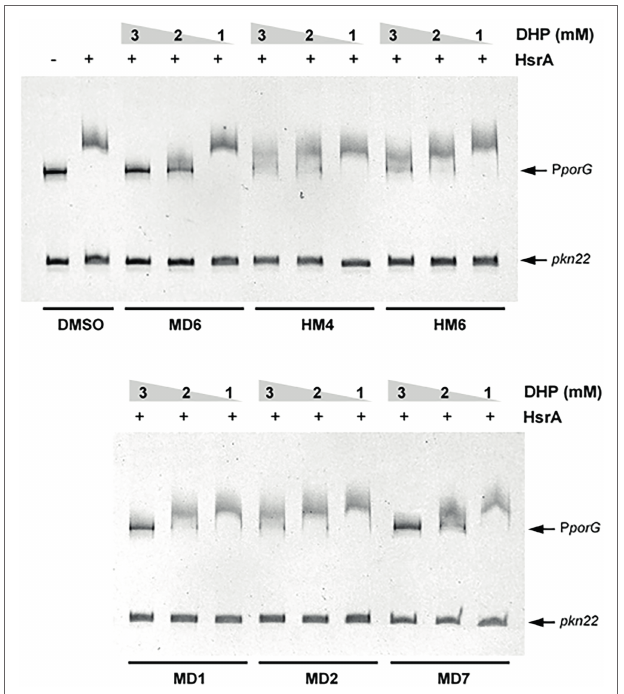
FIGURE 3 | Electrophoretic mobility shift assays (EMSAs) showing the ability of selected DHP-based HHQ derivatives to specifically inhibit the in vitro DNA binding activity of the H. pylori response regulator HsrA. The recombinant protein (5 μ M) was mixed with 120 ng of target promoter ( porGDAB operon) in the presence of 3, 2, and 1 mM of DHP. The Anabaena gene pkn22 was included as non-specific competitor DNA in all assays. Mixture of protein and DNA with DMSO (vehicle) instead of DHP was used as control. Protein-DNA interactions were analyzed by 6% PAGE using SYBR Safe® staining. Representative gel images are shown in a black-white inverted mode.